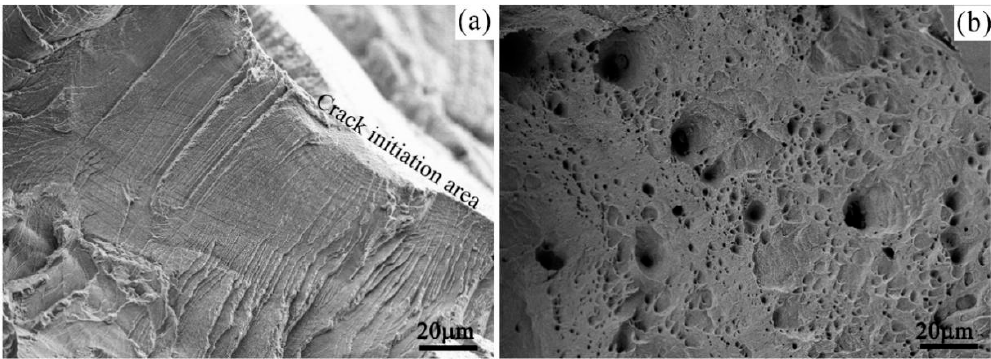
Figure 7. SEM images showing the fracture structure: ( a ) Crack initiation area; ( b ) dimples.